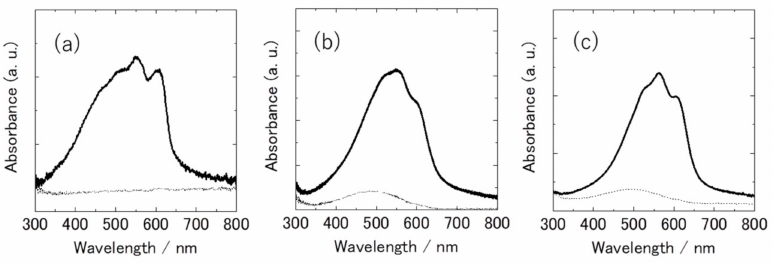
Figure 3. Polarized UV–vis absorption spectra of the friction-transferred PT ( a ), P3HT ( b ) and P3DDT ( c ) films. The polarization direction is parallel (solid line) and perpendicular (dashed line) to the drawing